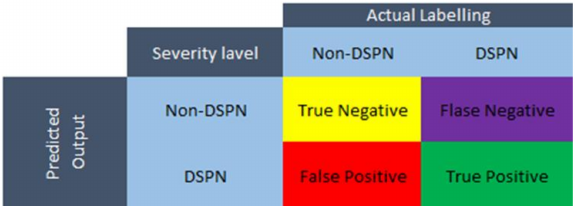
Figure 3. Confusion Matrix for two-class classification